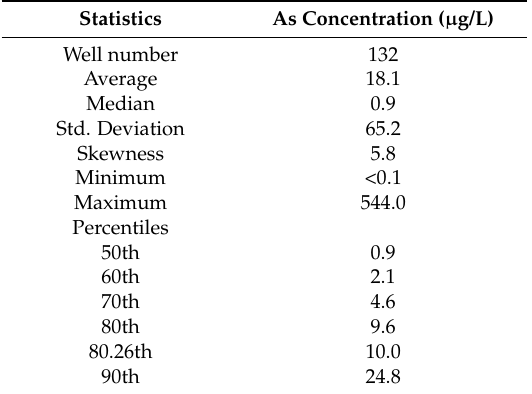
Table 2. Statistics regarding measured concentrations of As at the monitoring wells ( µ